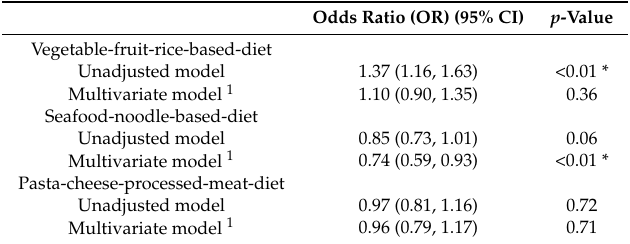
Table 2. Logistic regression analysis of dietary patterns with GDM outcome. Odds Ratio (OR) (95% CI) p -Value Vegetable-fruit-rice-based-diet Unadjusted